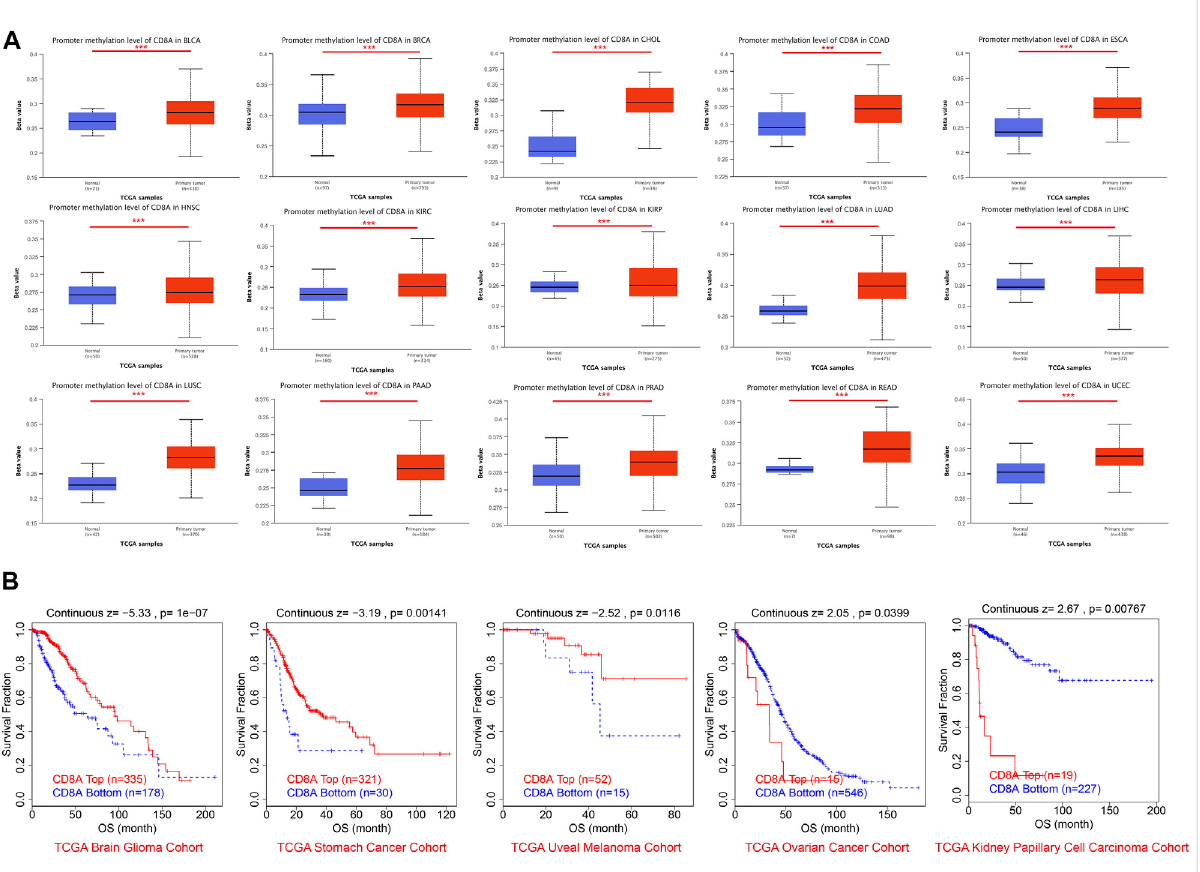
FIGURE 5 Epigenetic modi fi cation pro fi les of CD8A and its relationships with prognosis in pan-cancer datasets (A) Differential analysis of CD8A methylation levels based on UALCAN database (B) Correlation between CD8A methylation and prognosis as determined through Kaplan-Meier analysis based on TIDE database.